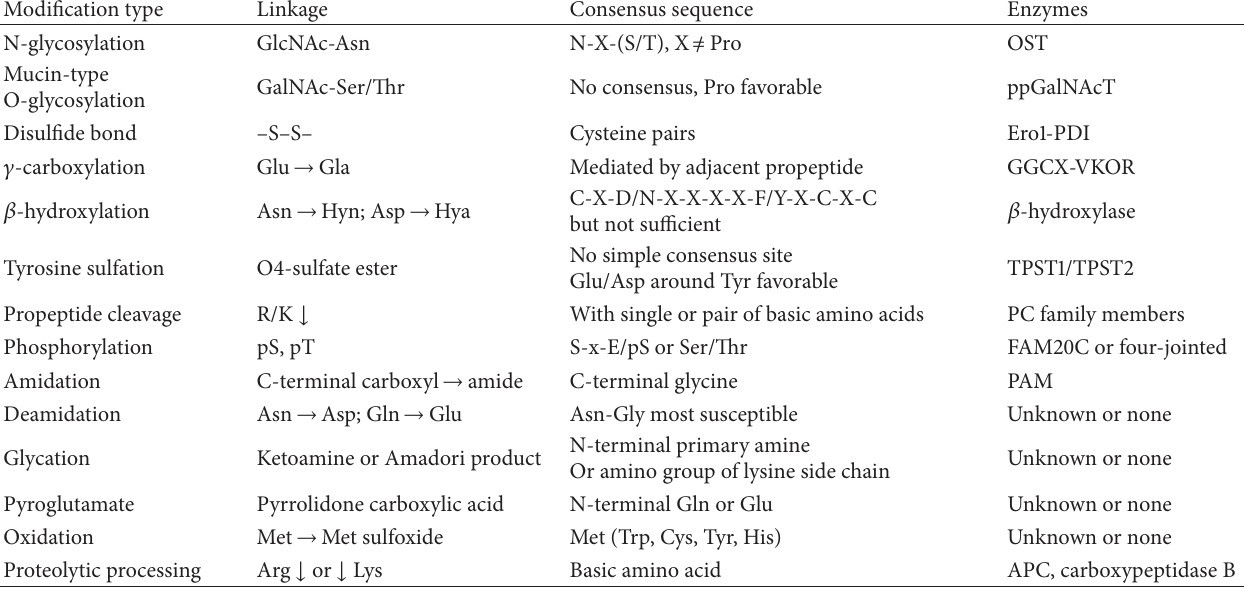
Table 1: Consensus motifs and enzymes responsible for therapeutic